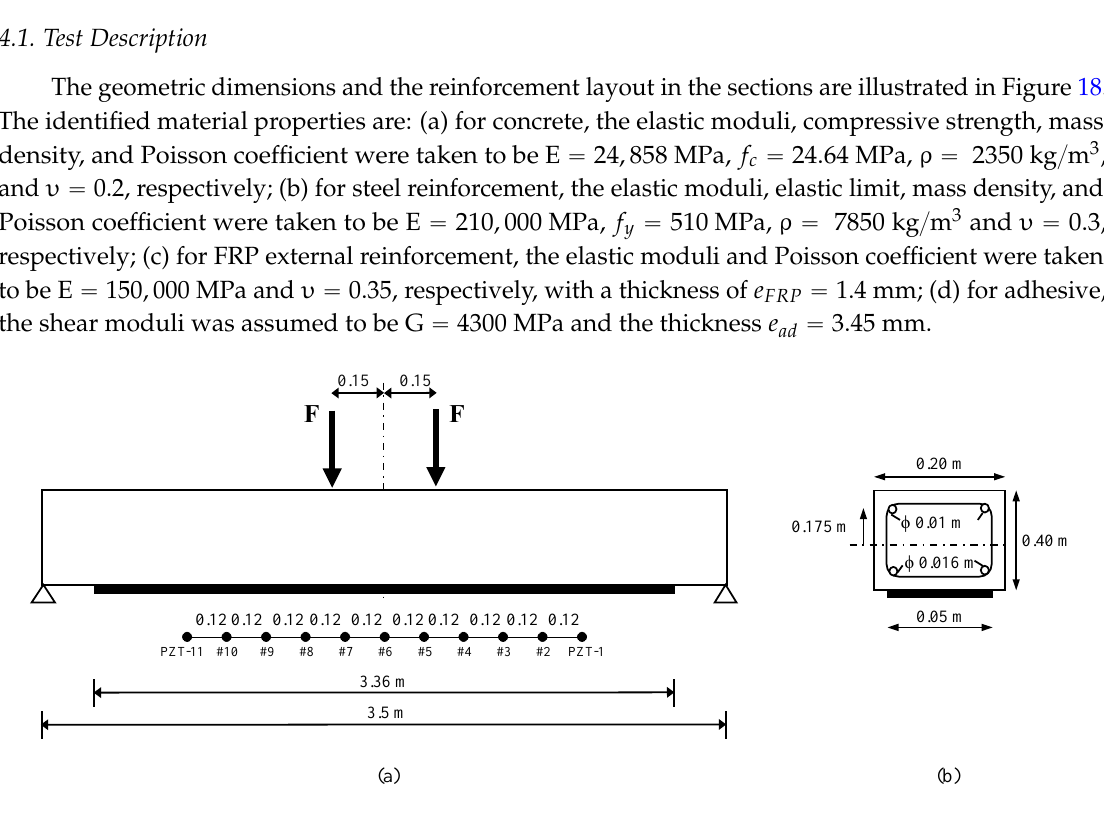
Figure 19. Experimental setup for the reinforced concrete beam externally strengthened with an FRP strip.